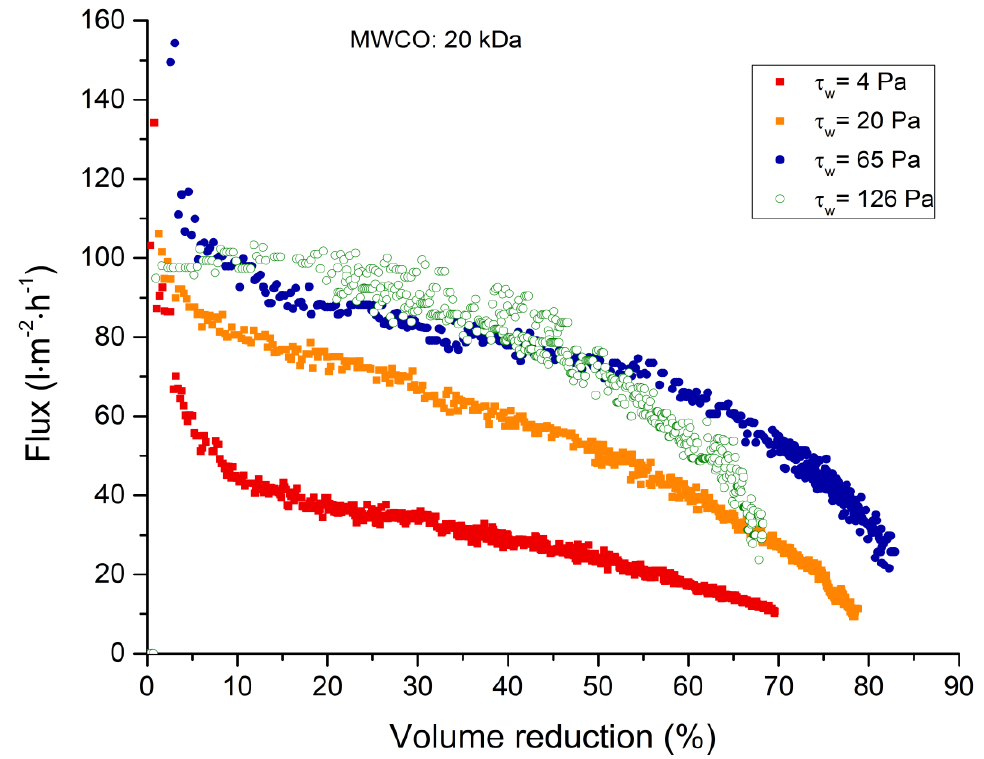
Figure 6. Flux loss is dependent on volume reduction during the filtration of spent sulfite liquor using a 20-kDa tubular ceramic membrane at a transmembrane pressure of 3 bar, a feed temperature of 60 °C, and at wall shear stresses of 4–126 Pa.